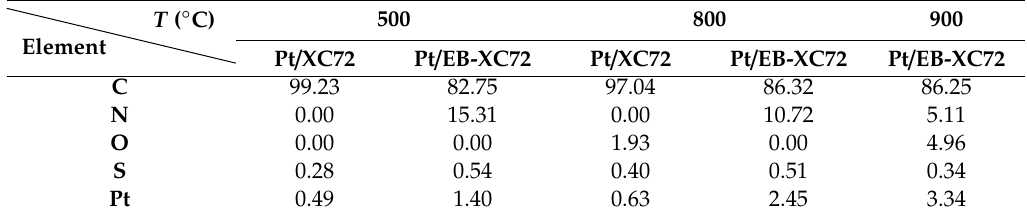
Table 3. Atomic % (Energy Dispersive X-Ray Spectroscopy (EDS)) of Pt-catalysts calcined at di ff erent temperatures.